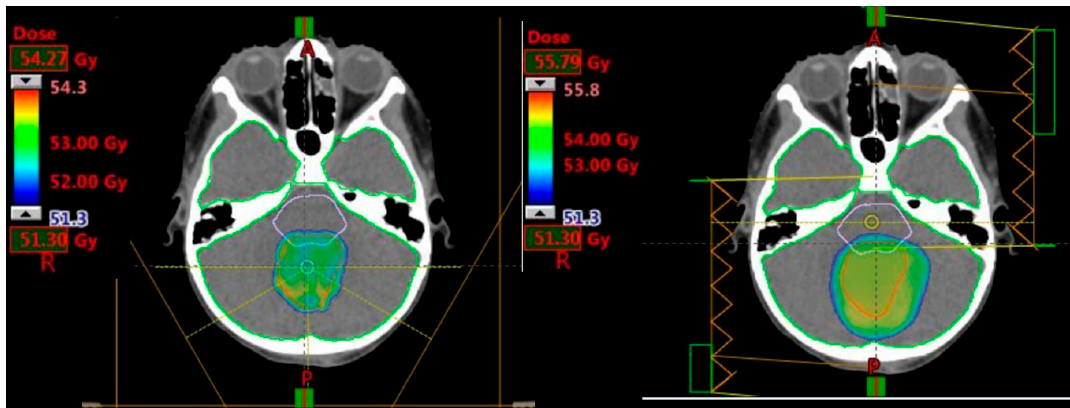
Figure 4. 13-year-old female with infratentorial medulloblastoma. Typical composite plan showing D95 coverage of the clinical target volume in IMPT (left) and IMRT (right) plans.